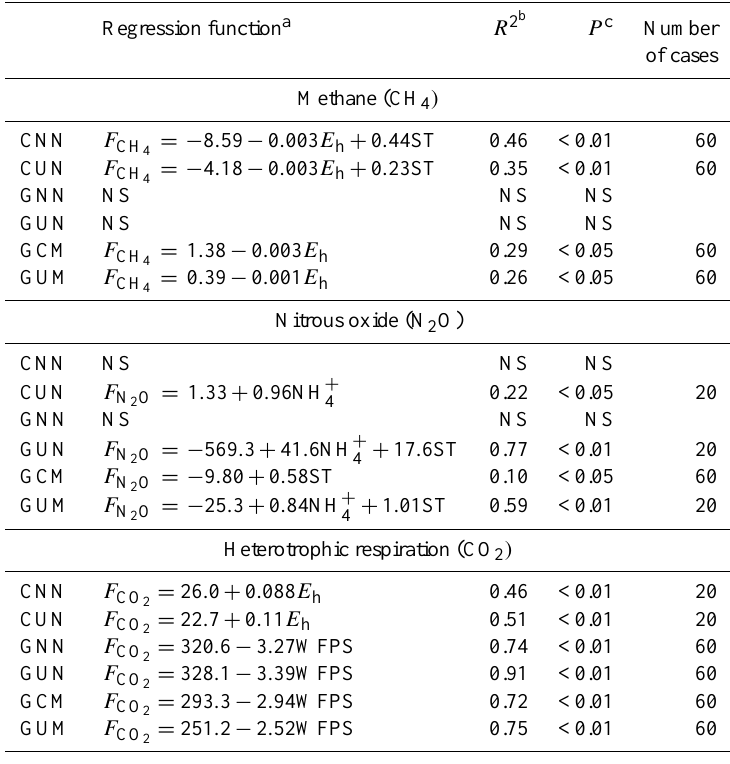
Table 4. Stepwise multiple linear regression analysis between soil environmental variables and the emissions of methane (CH 4 ) , nitrous oxide (N 2 O) and heterotrophic respiration (CO 2 ) for different fertilizer treatments during the rice-growing season.